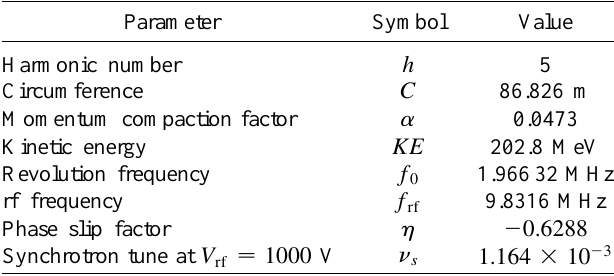
TABLE I. A list of parameters for the